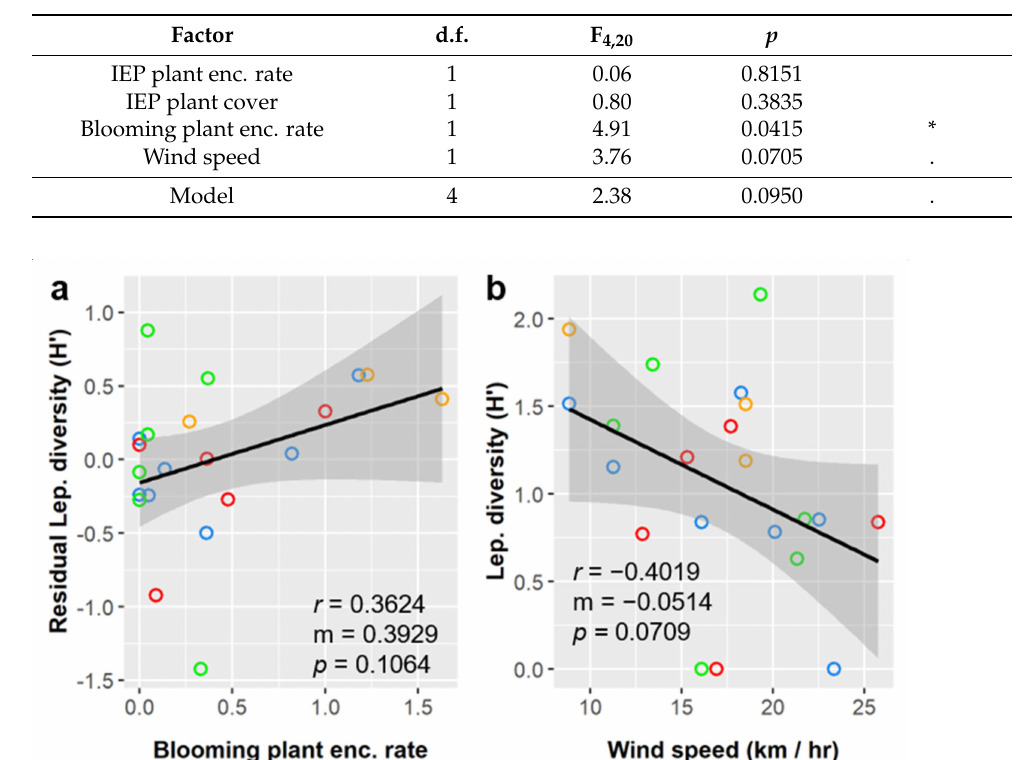
Table 8. Multiple regression results (after model pruning) using Type III sums of squares examining the effects of IEP plant encounter rate, IEP plant cover, blooming plant encounter rate, and wind